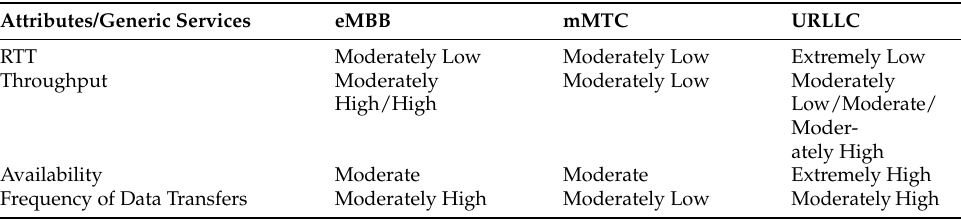
Table 4. The three generic services under 5G framework and their